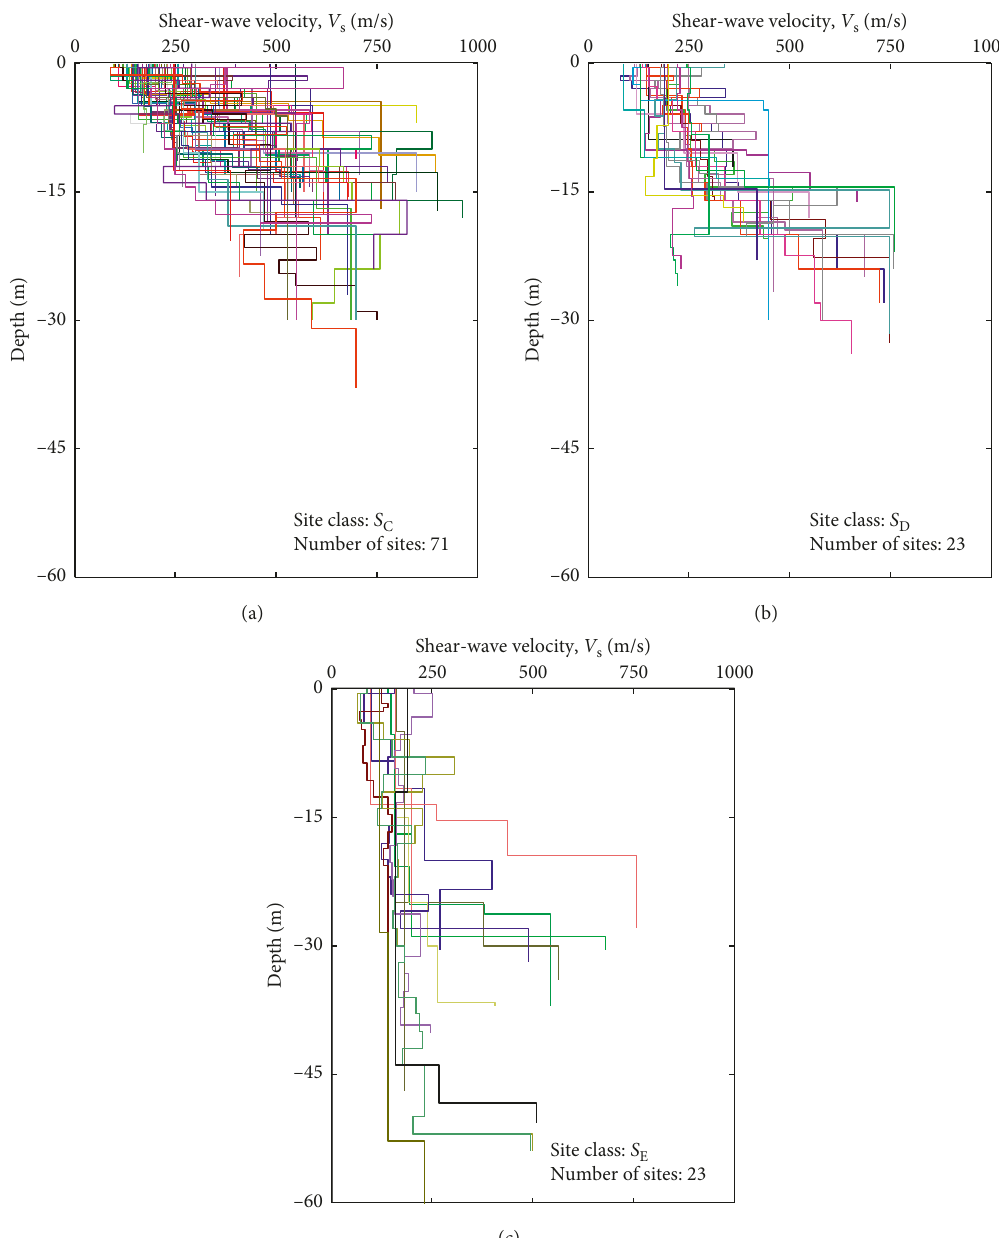
C, (b) S D , and (c) S E .